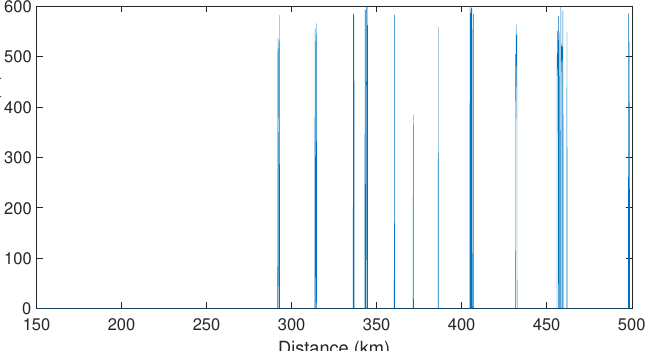
Figure 8. Curvature radius profile calculated with the proposed methodology with r C , th = 500